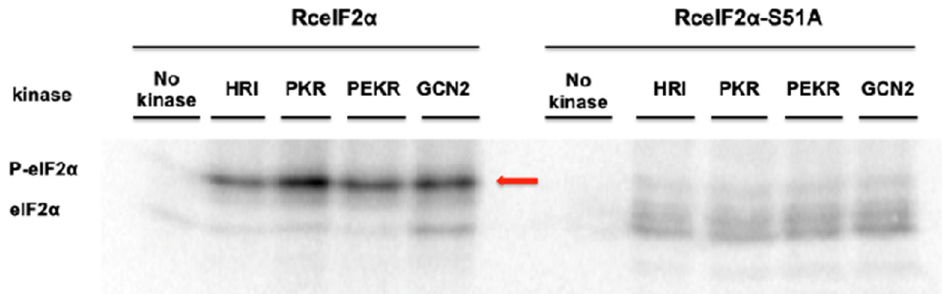
Figure 5. In vitro phosphorylation of cobia eIF2 α by purified recombinant mammalian eIF2 α -ki- nases 35 S-radiolabeled cobia eIF2 α , eIF2 α -S51A were synthesized in the reticulocyte TnT cell-free transcription/translation system by incubation at 30 °C for 30 min after which they were supple- mented with x units of purified mammalian recombinant HRI (EIF2AK1), PKR (EIF2AK2), PERK (EIF2AK3) or GCN2 (EIF2AK4) followed by incubation at 30 °C for an additional 10 min. Microcys- tin (0.5 μ M) was included to inhibit phosphatase activity. Each sample was diluted in an isoelectric focusing sample buffer prior to analysis. Samples were subjected to vertical slab isoelectric focusing (VSIEF) to separate phosphorylated and non-phosphorylated forms, using a narrow pH range of 4.5–6. Proteins transferred to PVDF and visualized using the Typhoon imager. The red arrow indi- cates the position of phosphorylated eIF2 α